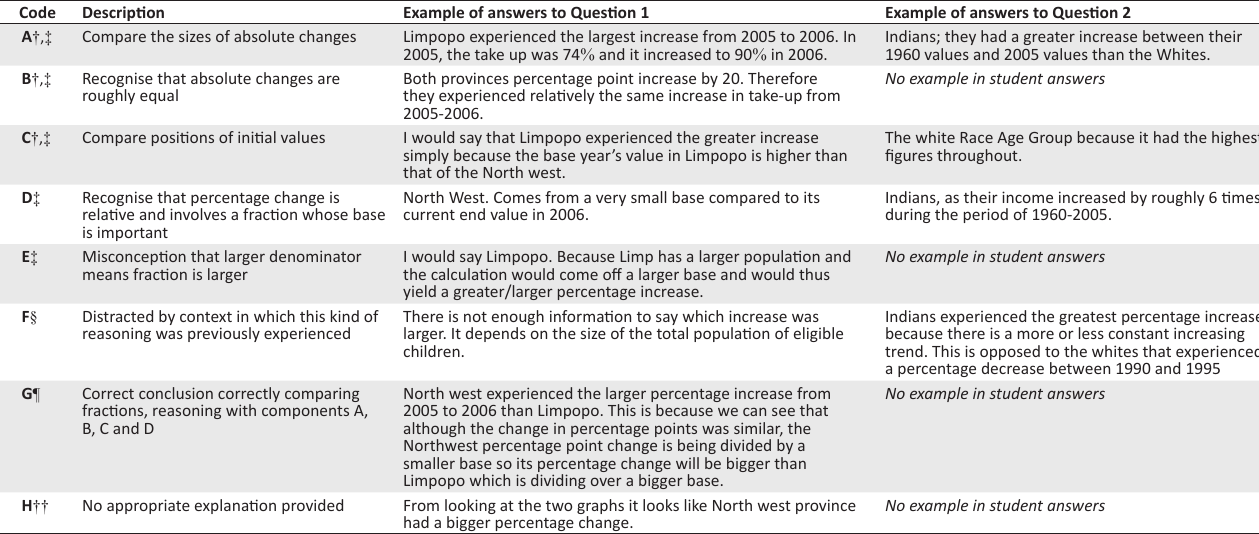
TABLE 1: Coding key for Question 1 and Question